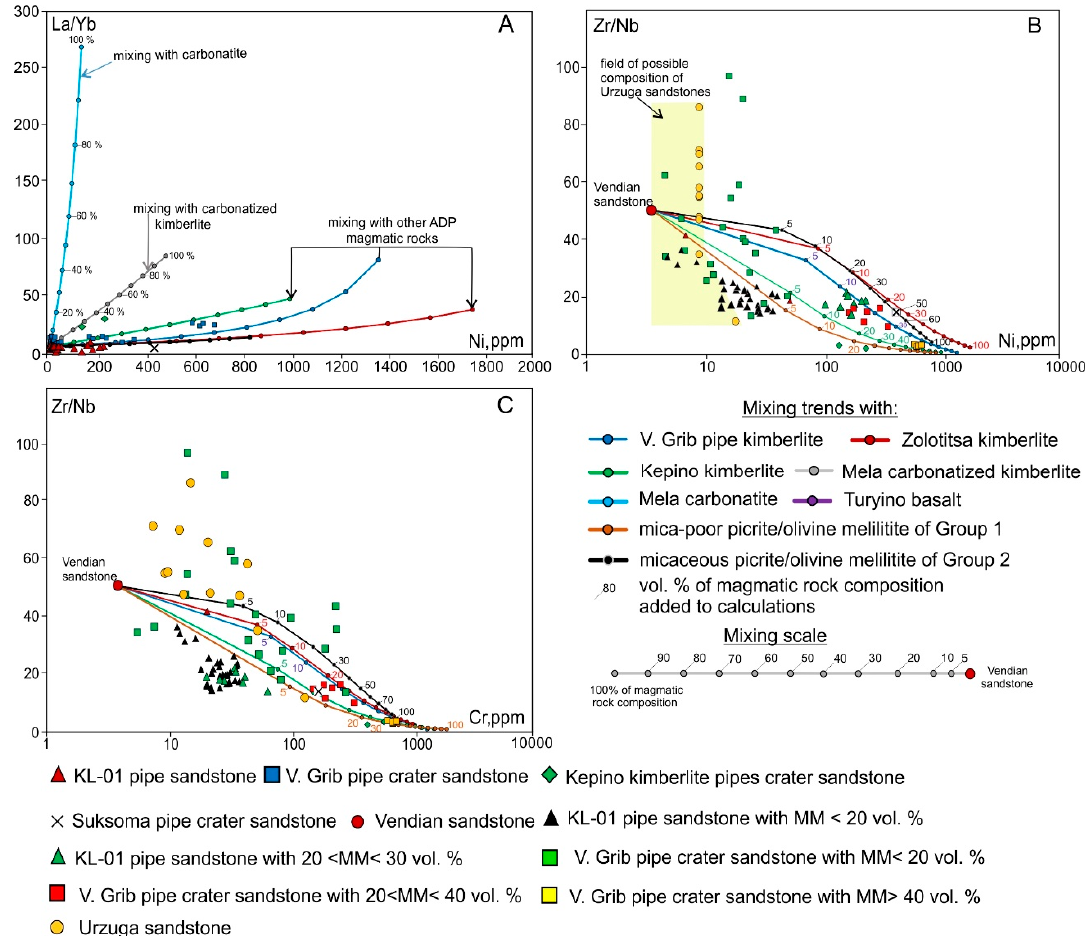
Figure 14. Trends of binary mixing between Vendian sandstones and typical ADP magmatic rocks based on correlations of La/Yb-Ni ( A ), Zr/Nb-Ni ( B ) and Zr/Nb-Cr ( C ). The end-members of mixing are the average compositions of Vendian sandstones and typical ADP magmatic rocks.